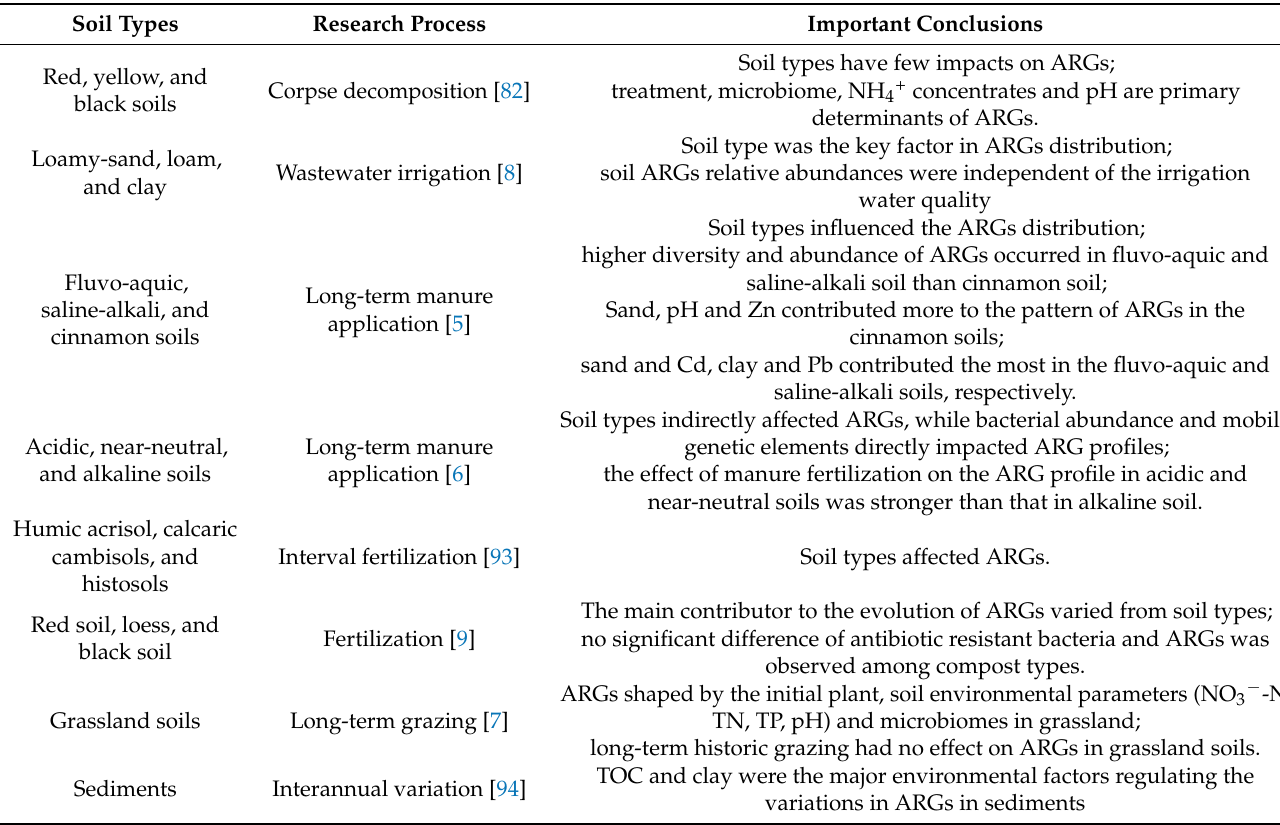
Table 2. Research on the effects of soil types on antibiotic resistance genes (ARGs) abundance.